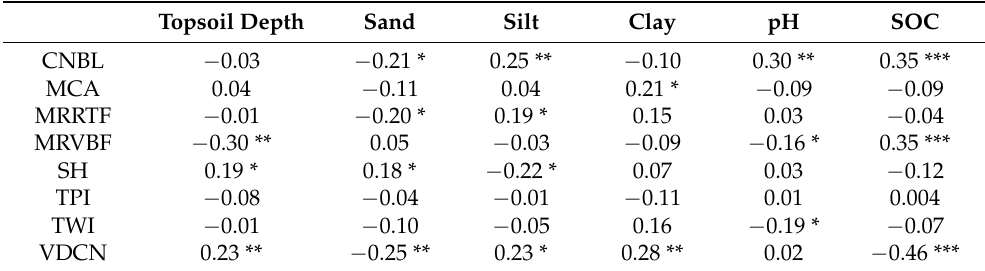
Table 3. Spearman’s rank correlation rho between soil properties and terrain